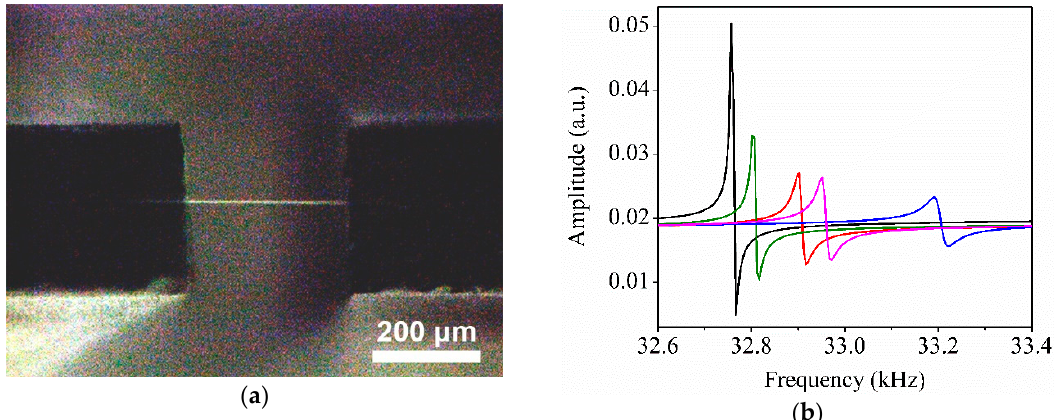
Figure 3. ( a ) Optical microscope image of the CP30-quartz tuning fork (QTF). ( b ) Variations in the resonance frequency peaks after mounting an electrospun fiber (black, bare QTF; red, P30-QTF; green, P60-QTF; blue, CP30-QTF; and pink, CP60-QTF).